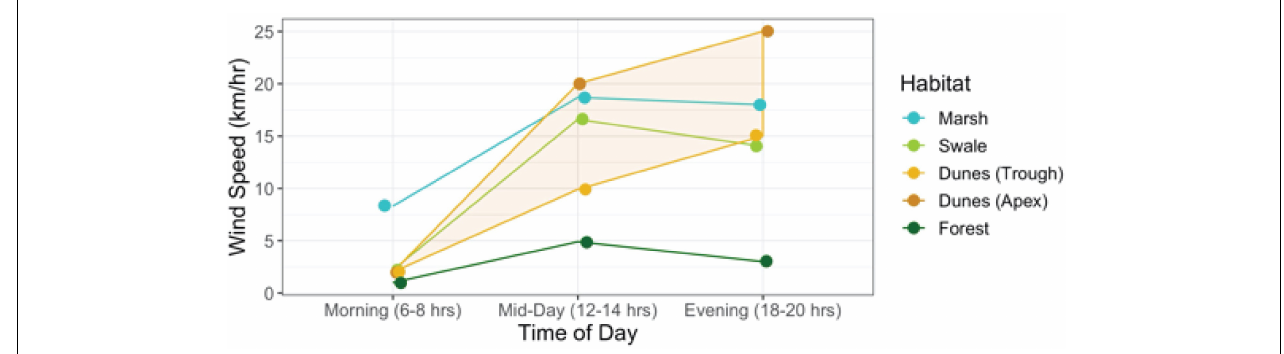
FIGURE 6 | Relationship between wind speeds per habitat at varying times of the day (morning, mid-day, and evening) (Interaction Habitat × Time of Day: F 6 , 710 = 47.5; p < 0.0001). The shaded band highlights the areas in the dunes between the apex and trough where wind speeds are at their highest and lowest, respectively.